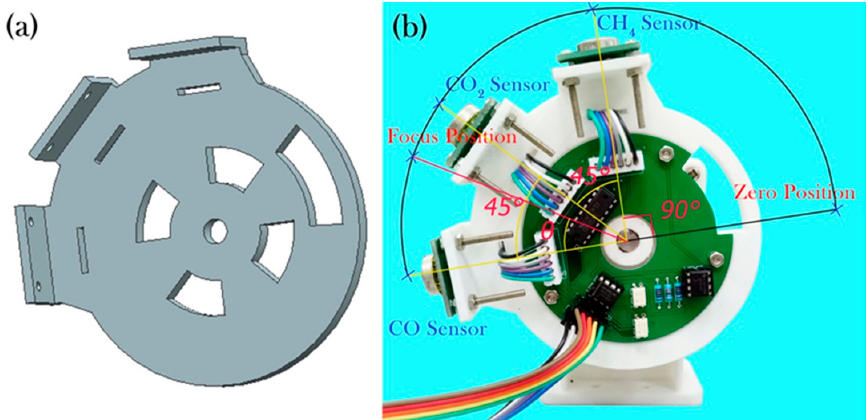
Figure 3. ( a ) CAD model of the disc for mounting three detectors; ( b ) Photograph of the disc with a sealed circuit board and three pyroelectric detectors for the detection of CO, CO 2 and CH 4 .